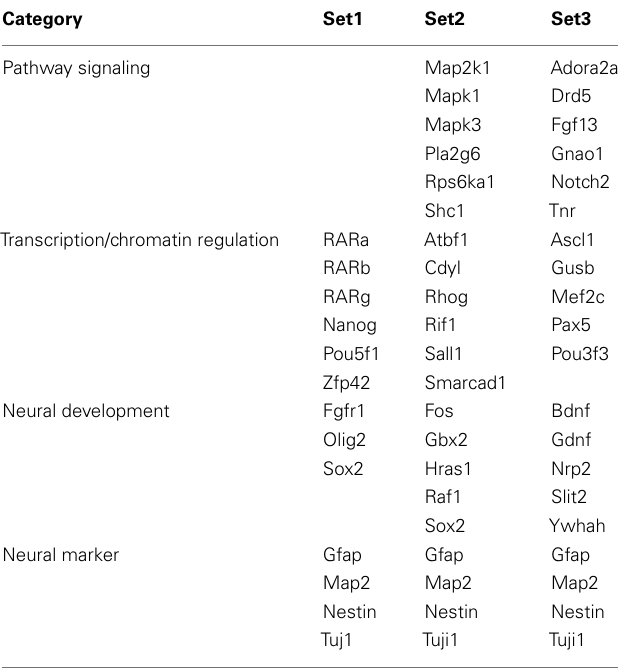
Table 1 | Lists of gene sets for identifying gene